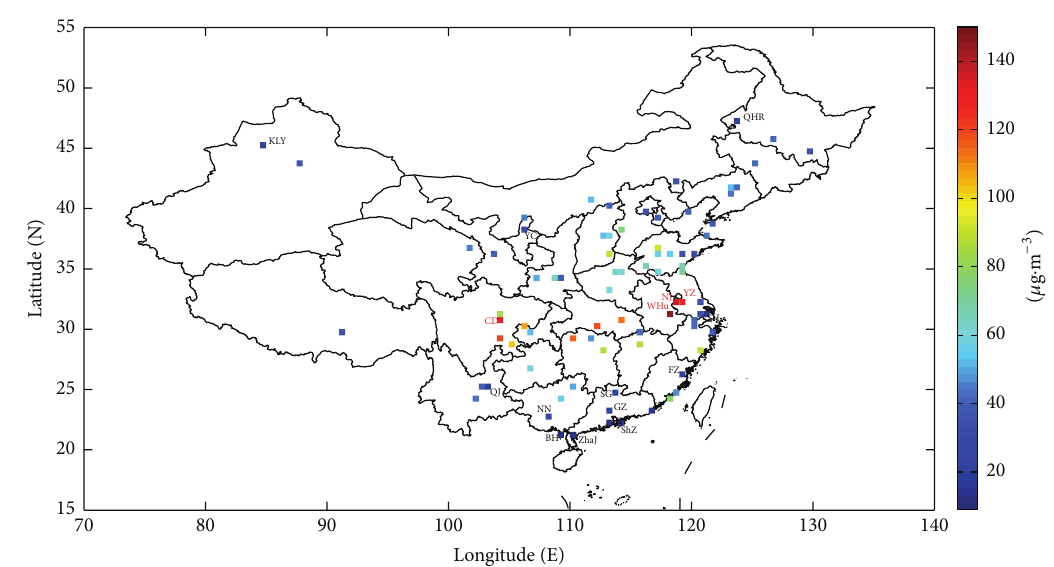
Figure 5: The observations at 18 May